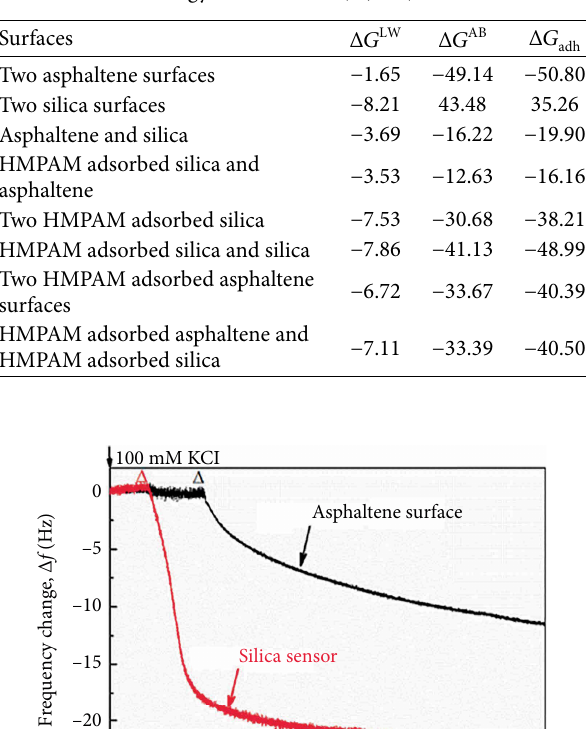
Table 4: Free energy of interaction (mJ/m 2 ) between surfaces.